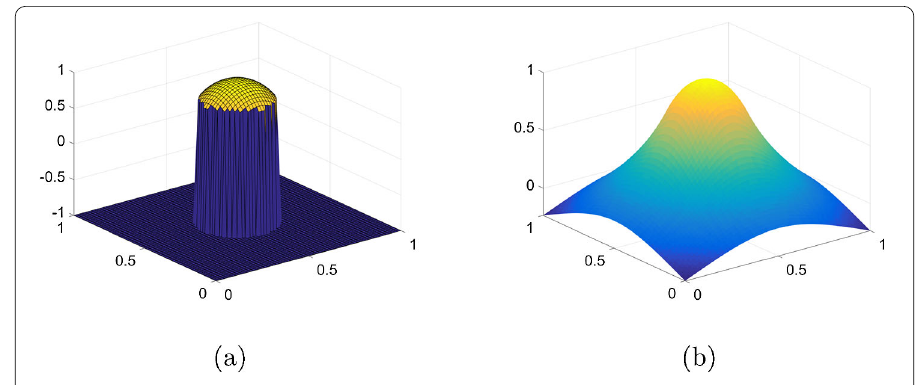
Figure 4 The true solution to the linear problem for the obstacle ϕ 2 (5.4) at resolution 64 × 64. (a) The obstacle ϕ 2 and (b) the true solution u ∗ (5.6)